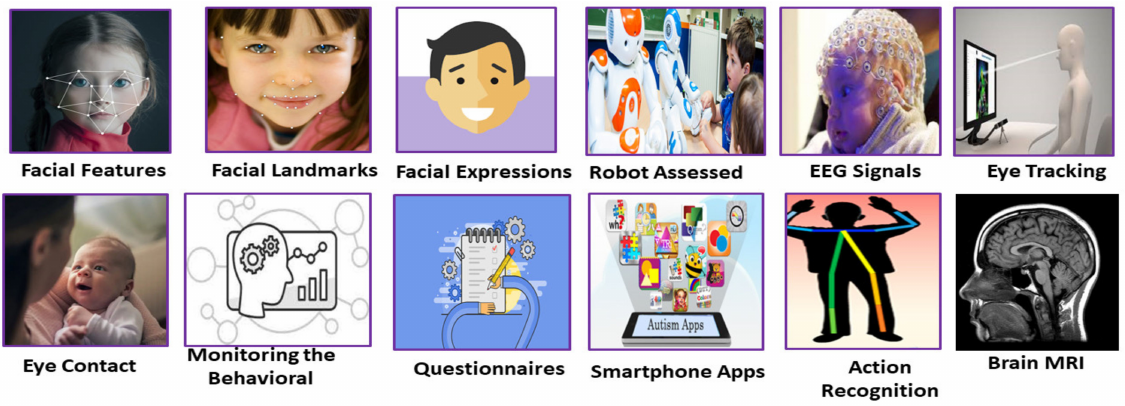
Figure 1. Different types of technology to detect